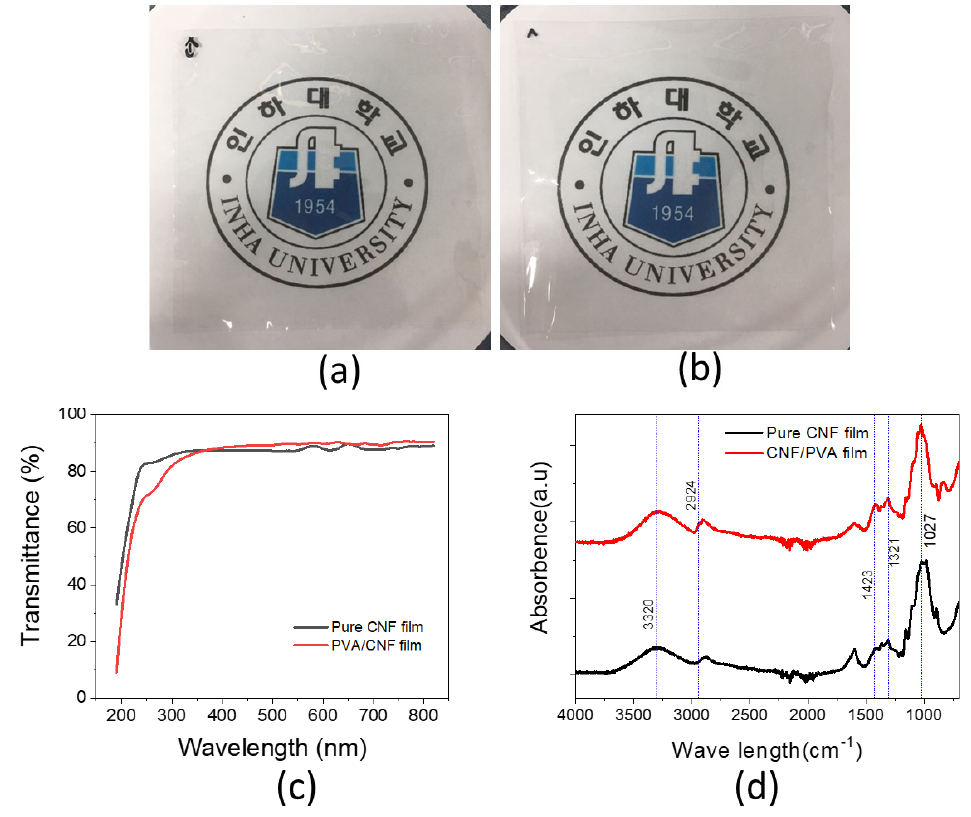
Figure 5. ( a ) Photographs of the pure CNF film; ( b ) a photograph of the CNF/PVA film; ( c ) UV-vis. Spectra; ( d ) FTIR spectra.